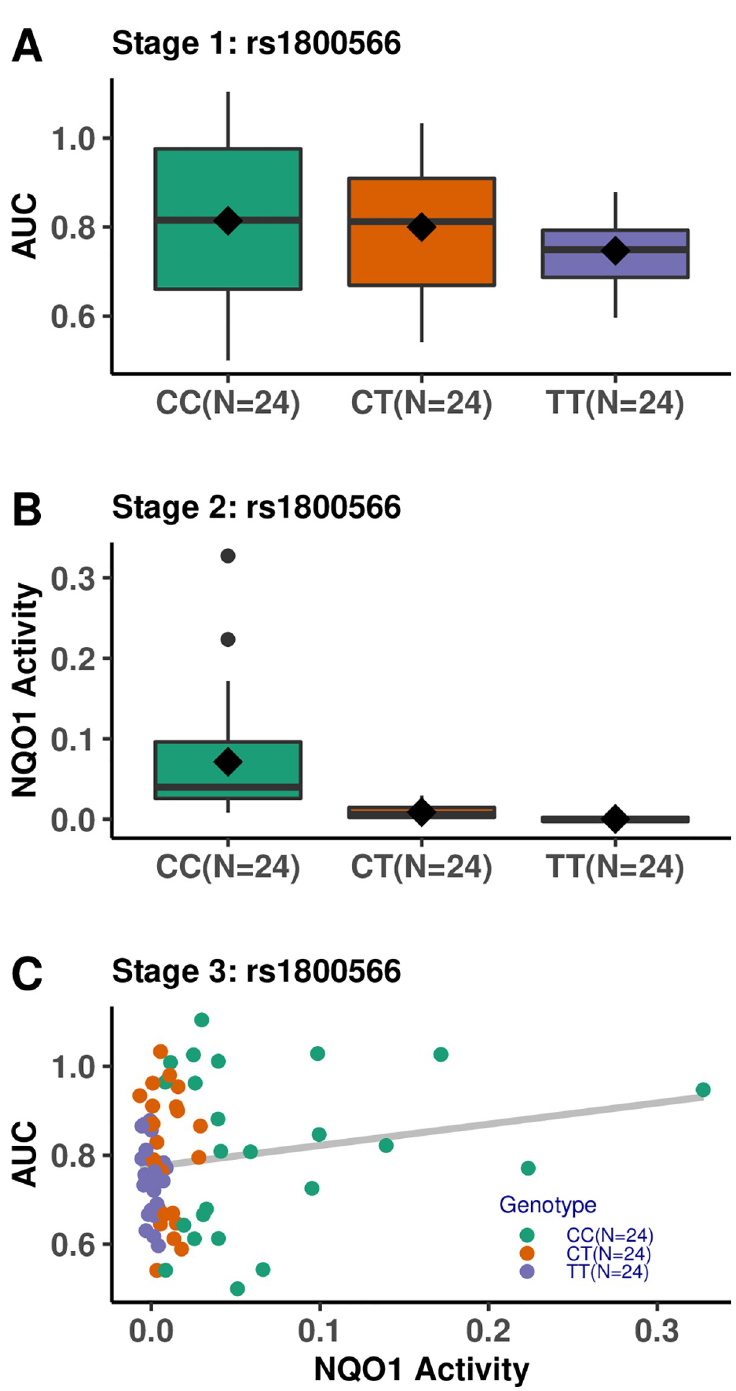
Fig 5. Associations for the pQTL model between genotype at rs1800566, NQO1 protein activity, and arsenic trioxide response data in 72 LCLs from the 1000 Genomes Project. (A) Stage 1: Association between SNP rs1800566 and AUC for arsenic trioxide. (B) Stage 2: Association between SNP rs1800566 and NQO1 protein activity. (C) Stage 3: Association between NQO1 protein activity and AUC for arsenic trioxide.